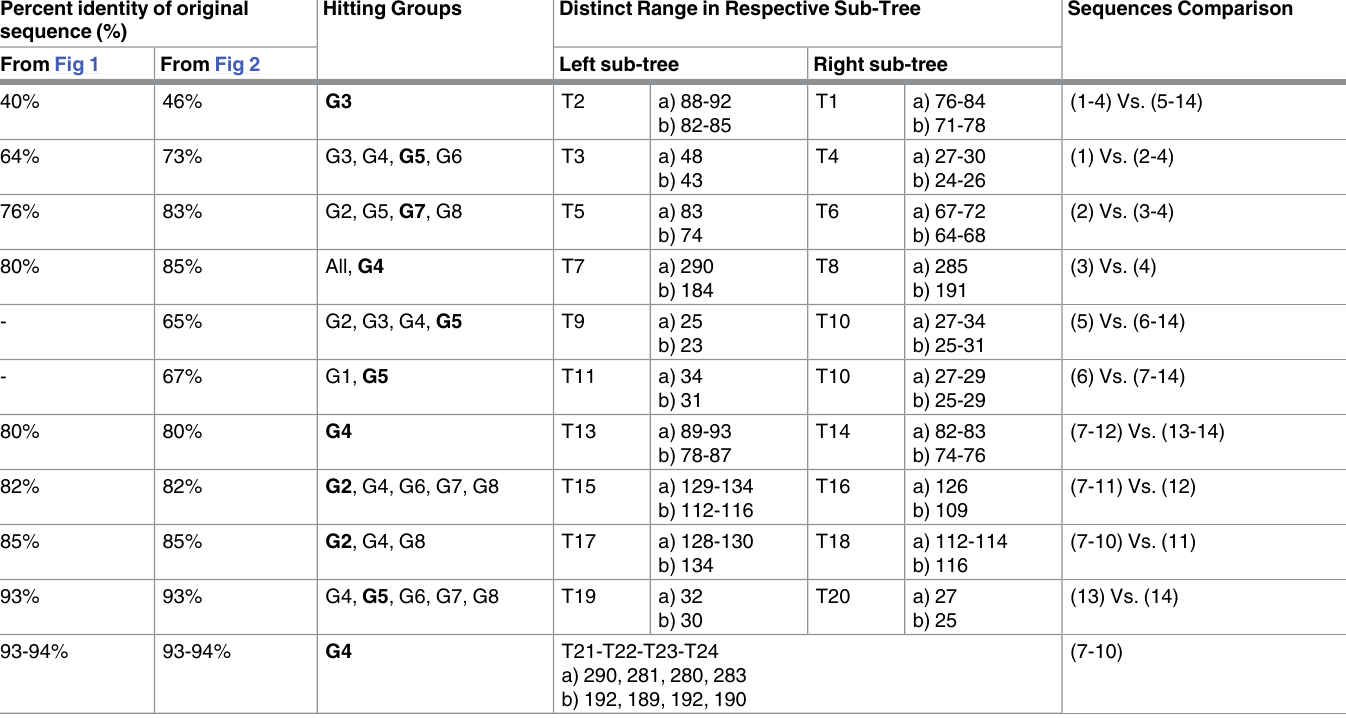
Table 12. Distinct ranges of every branch of the phylogenetic tree obtained from Table 11, percentage (%) identity of each branching point from Fig 2. Percent identity of original Hitting Groups sequence (%)